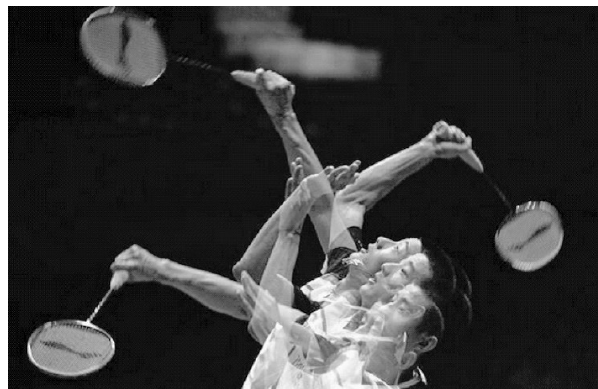
Fig. 5 Image of the player’s batting process